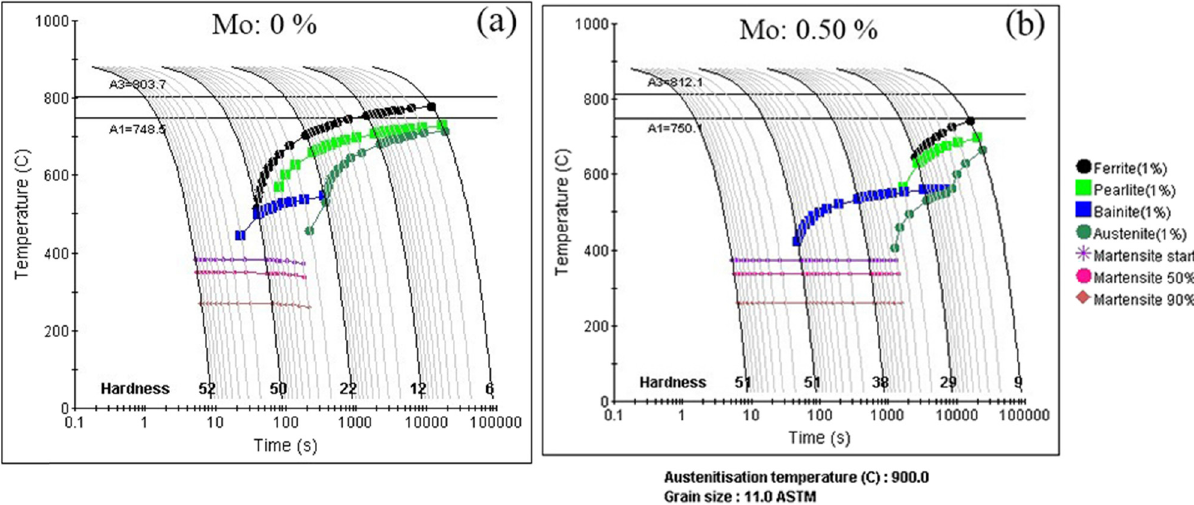
Figure 18: CCT curves calculated by J Mat Pro software: ( a ) steel 7#; ( b ) steel